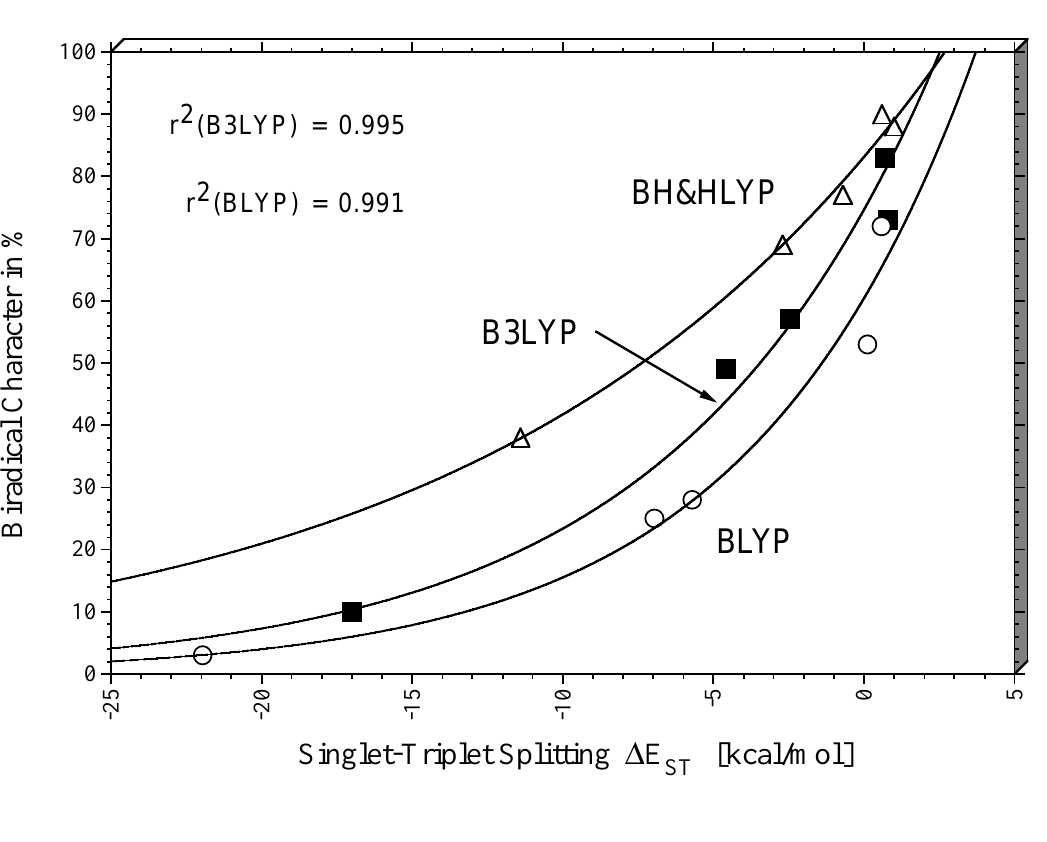
Figure 6: The biradical character of molecules 1 - 5 in their lowest singlet state calculated as 100 × FON(LUMO). REKS(2,2)/6-31G(d)